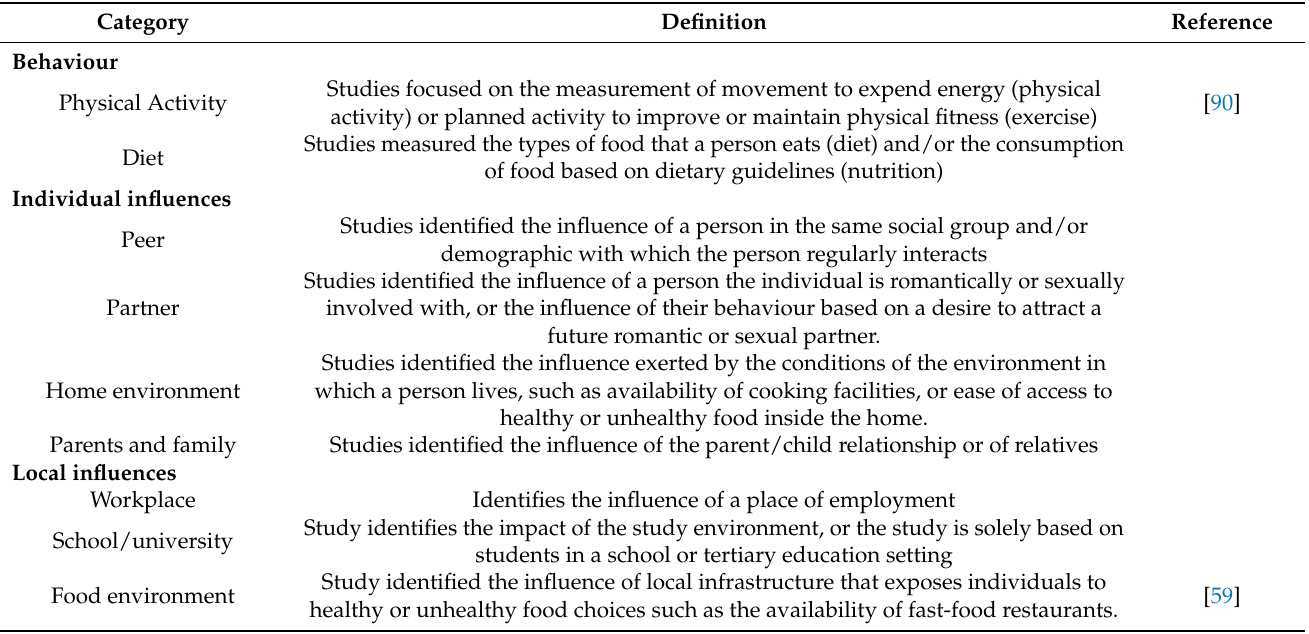
Table A1. Coding frame to categorise scoping review studies according to behaviour and the